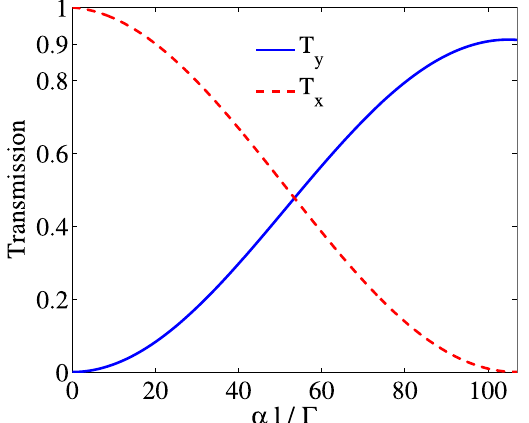
(solid) versus α l . The taken parameters y